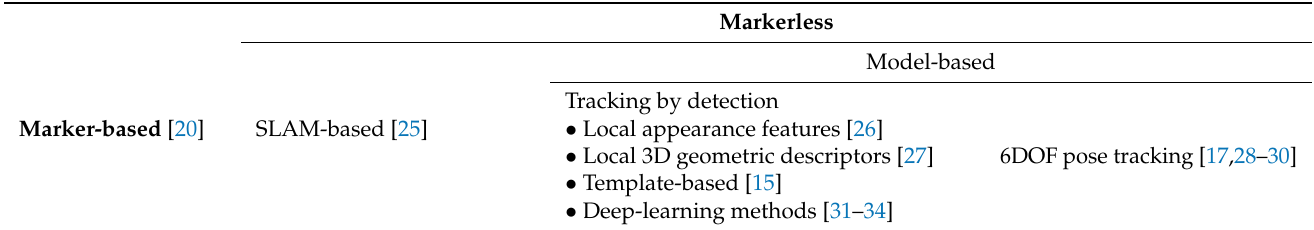
Table 1. Main AR tracking